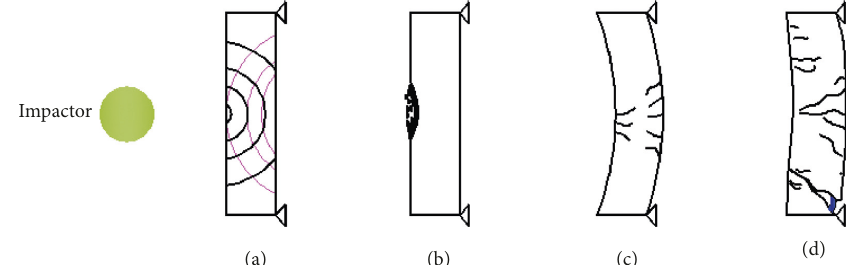
Figure 8: Impact response of RC member: (a) transmission of stress wave; (b) local damage point; (c) global flexural failure; (d) global shear failure.